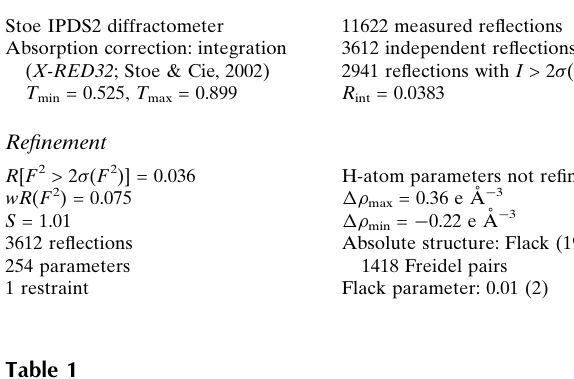
Hydrogen-bond geometry (A˚ , (cid:4)